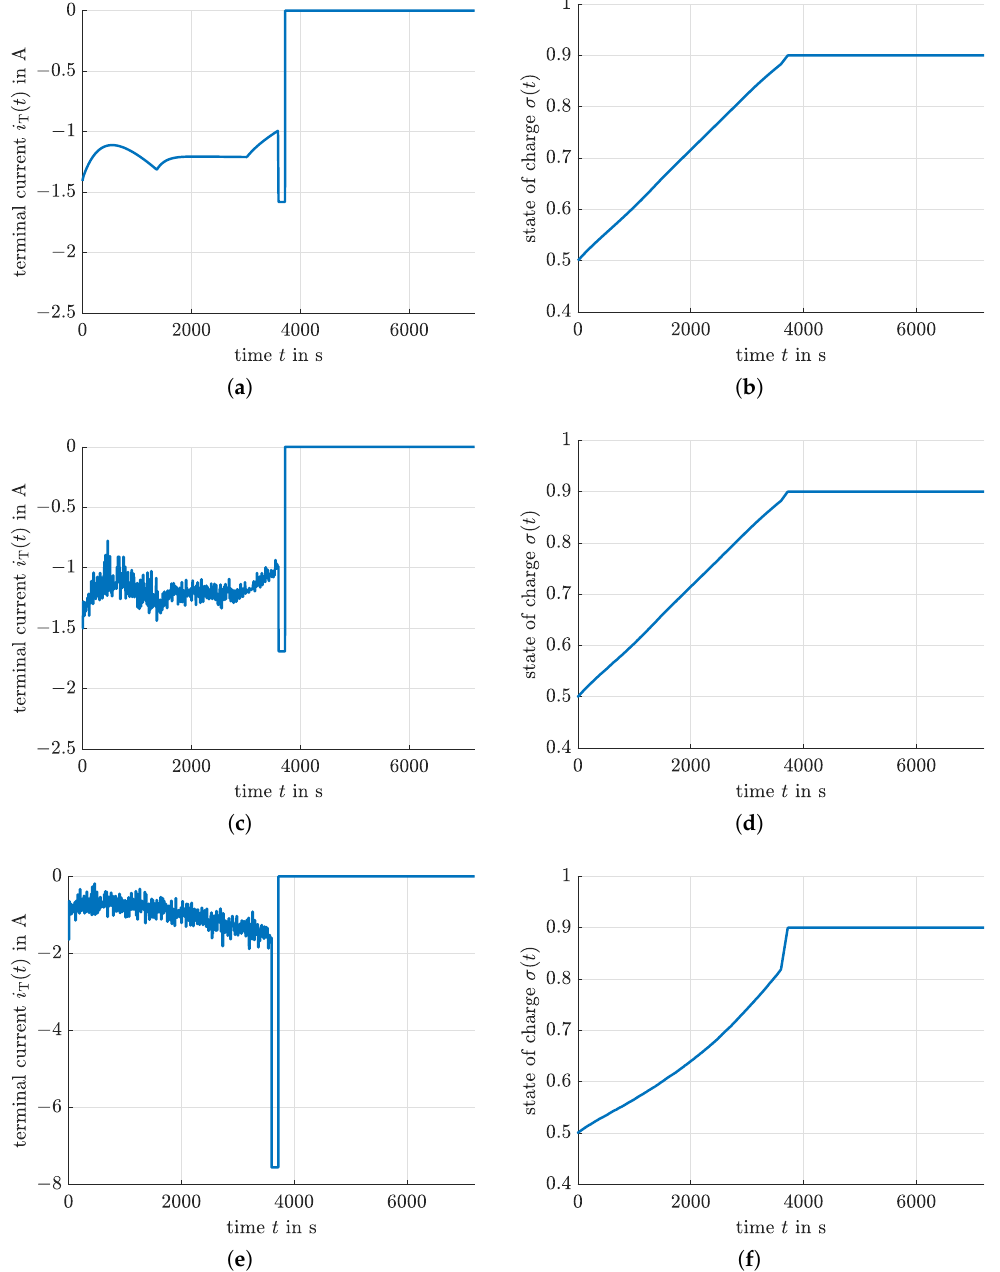
Figure 11. Evaluation of the control optimization by means of reinforcement learning. ( a ) Terminal current i T ( t ) (optimization and evaluation without noise); ( b ) SOC σ ( t ) (optimization and evaluation without noise); ( c ) Terminal current i T ( t ) (optimization without noise; evaluation with noise); ( d ) SOC σ ( t ) (optimization without noise; evaluation with noise); ( e ) Terminal current i T ( t ) (optimization and evaluation with noise); ( f ) SOC σ ( t ) (optimization and evaluation with